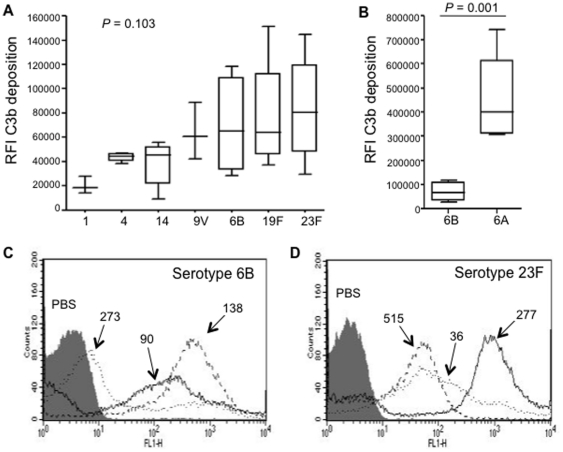
C3b/iC3b deposition in 25% human serum on clinical isolates of S. pneumoniae measured using flow cytometry and expressed as an FI.(A) Median (IQR) FI of C3b/iC3b deposition on at least 3 clinical S. pneumoniae isolates from serotypes 1, 4, 7F, 9V, 6B, 19F and 23F. Data were analysed using the Kruskal Wallis test and showed no significant differences between serotypes shown in this panel. (B) Median FI of C3b/iC3b deposition on clinical isolate S. pneumoniae strains of serotype 6B and 6A. P value represents the results of a Mann-Whitney U Test. (C) and (D) Representative flow cytometry histograms of C3b/iC3b deposition on serotype 6B and 23F strains. Labels refer to strain ST.